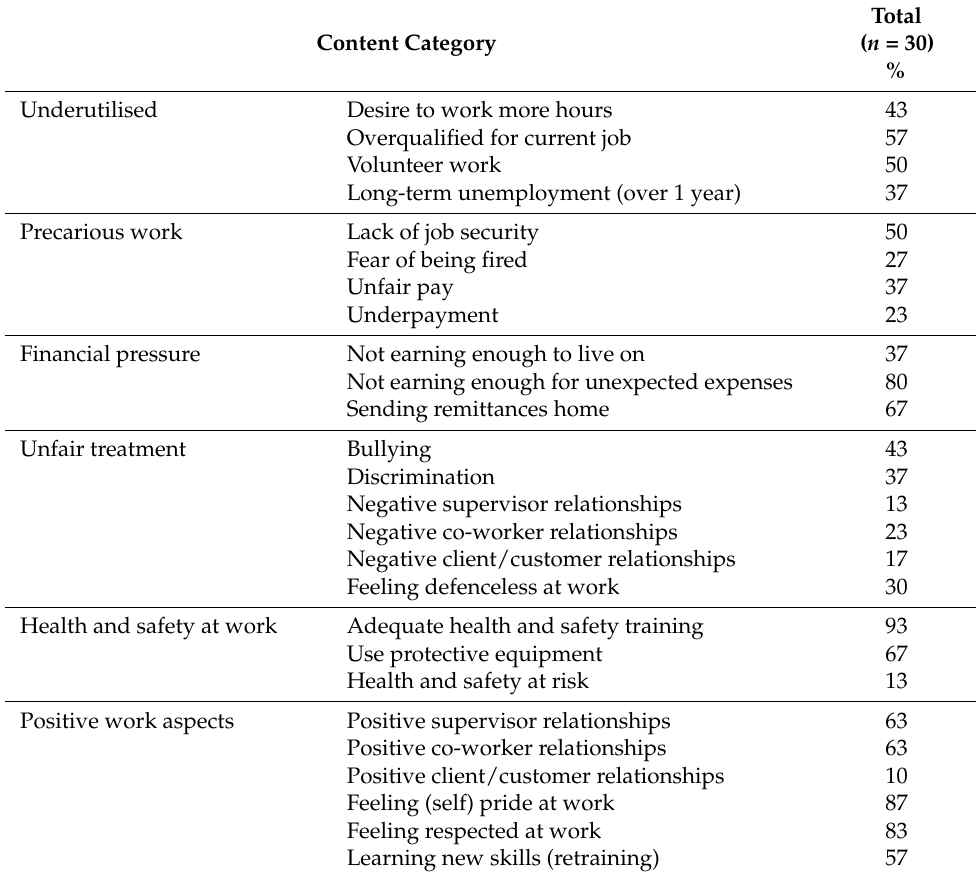
Table 4. Content analysis summary (expressed as a percentage of total participants and country of birth) reporting on each